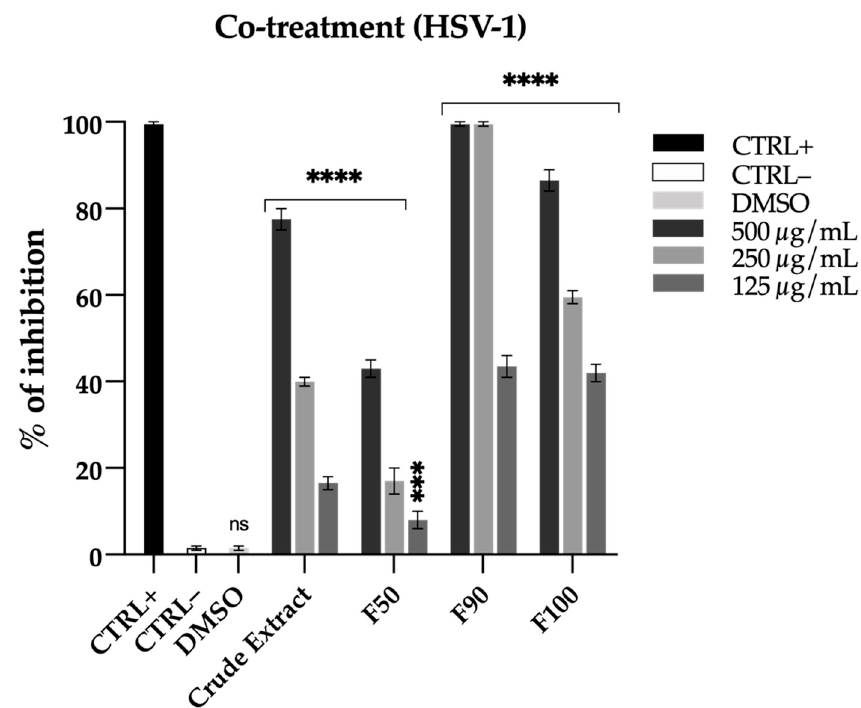
Figure 6. Antiviral effects of SV2 SW fractions against herpes simplex virus 1 (HSV-1) in co-treatment experiments. Vero cells were simultaneously infected with HSV-1 and treated with DMSO vehicle and different concentrations (125, 250, and 500 µ g/mL) of the SV2 SW crude extract and fractions F50, F90, and F100. The negative control is represented by untreated cells. The Greco extract at 50 µ g/mL was used as positive control (CTRL+). Data are means of three independent experiments. Statistical significances are referred to the negative control (untreated cells). Differences between groups were determined by analysis of variance (ANOVA) and Dunnett’s test was used for multiple comparisons with the control. * p < 0.0332, **** p < 0.0001, ns (not significant).